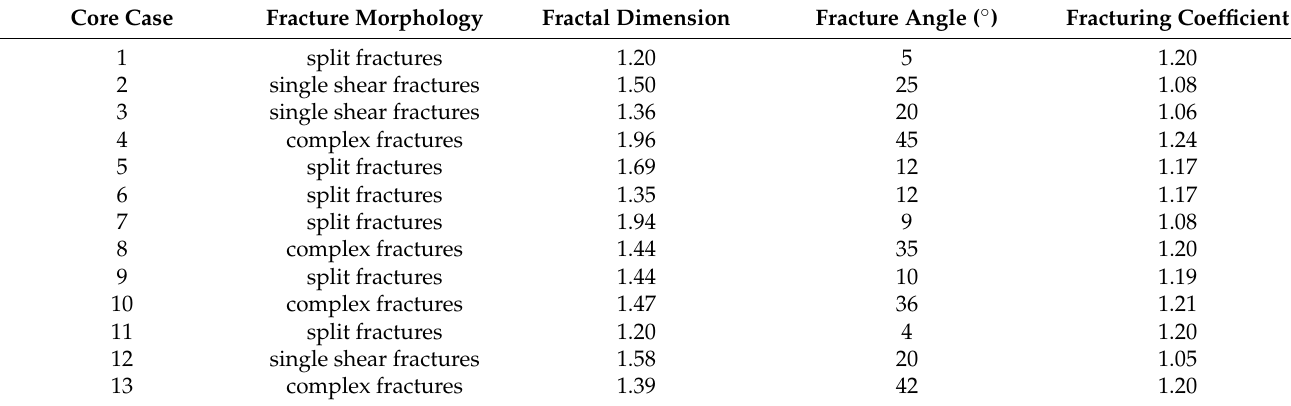
Figure 3. Schematic of the fracture angle on the side of the rock pillar. Table 2. Fracture morphology parameters.